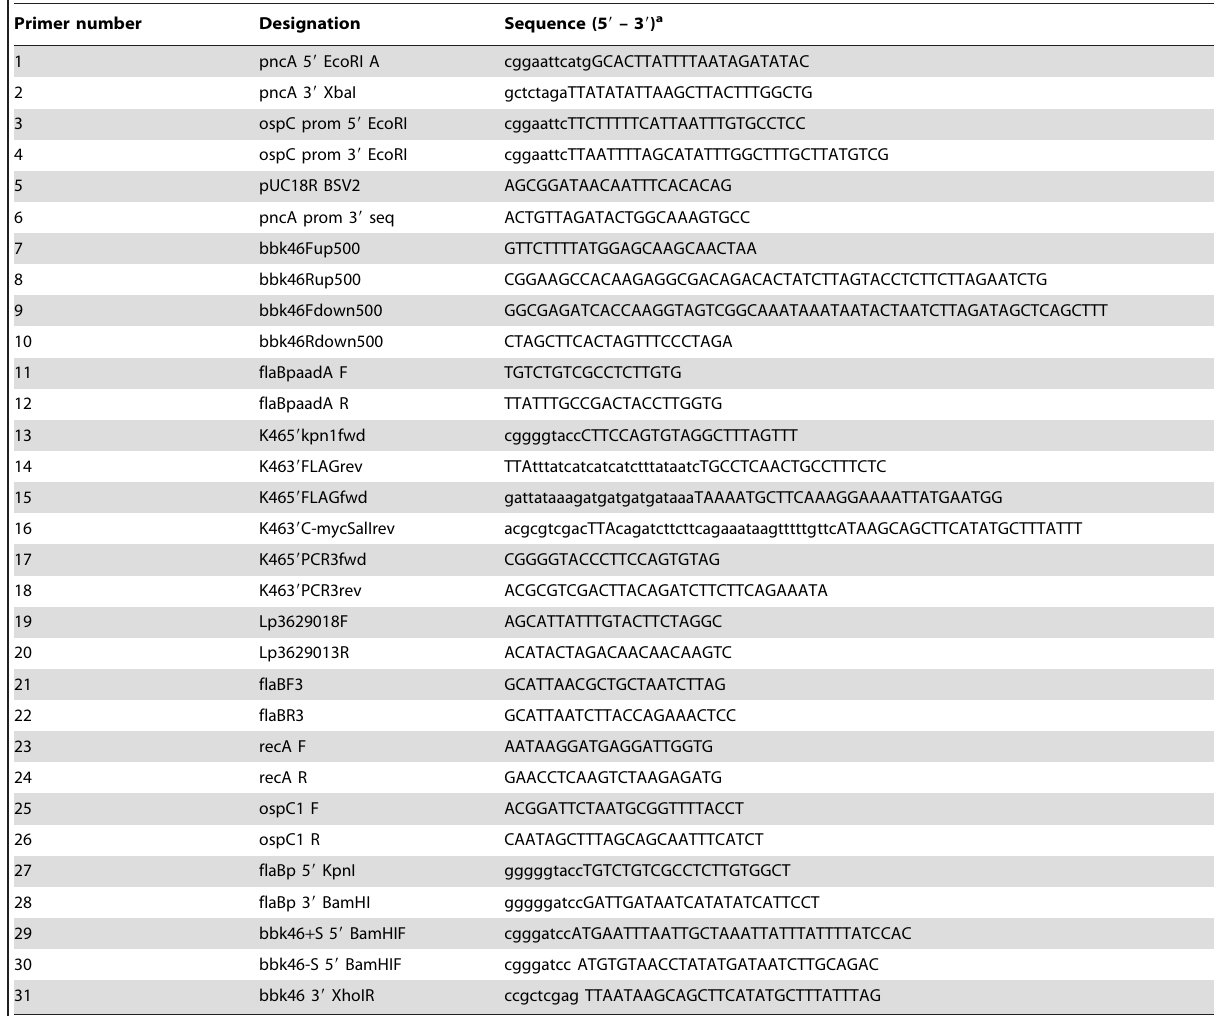
Table 5. List of primers used in this